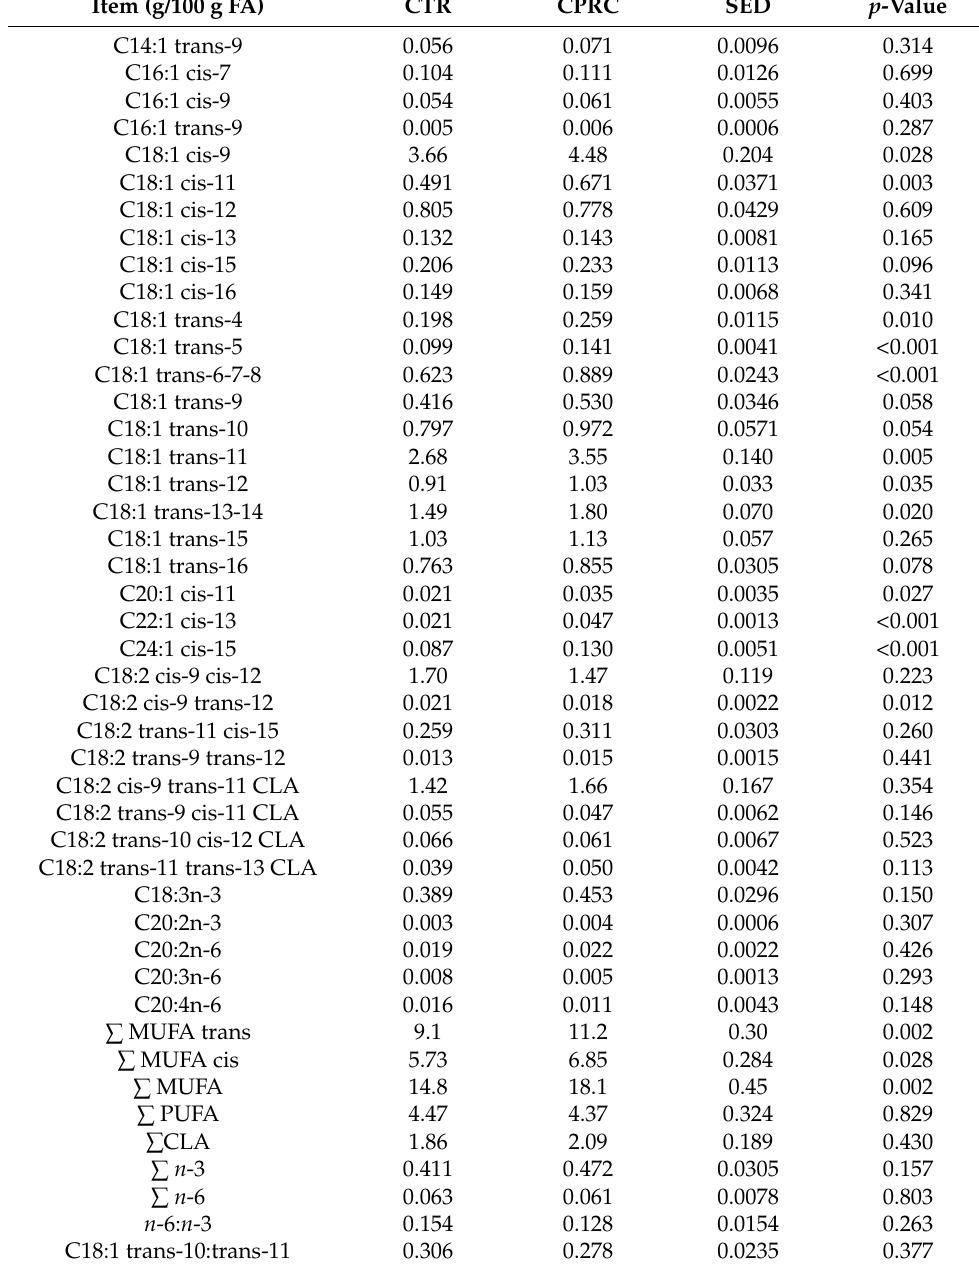
Table 4. Effect of including cold-pressed rapeseed cake in the concentrate of dairy cows on ruminal unsaturated fatty acid composition (LSM, n =